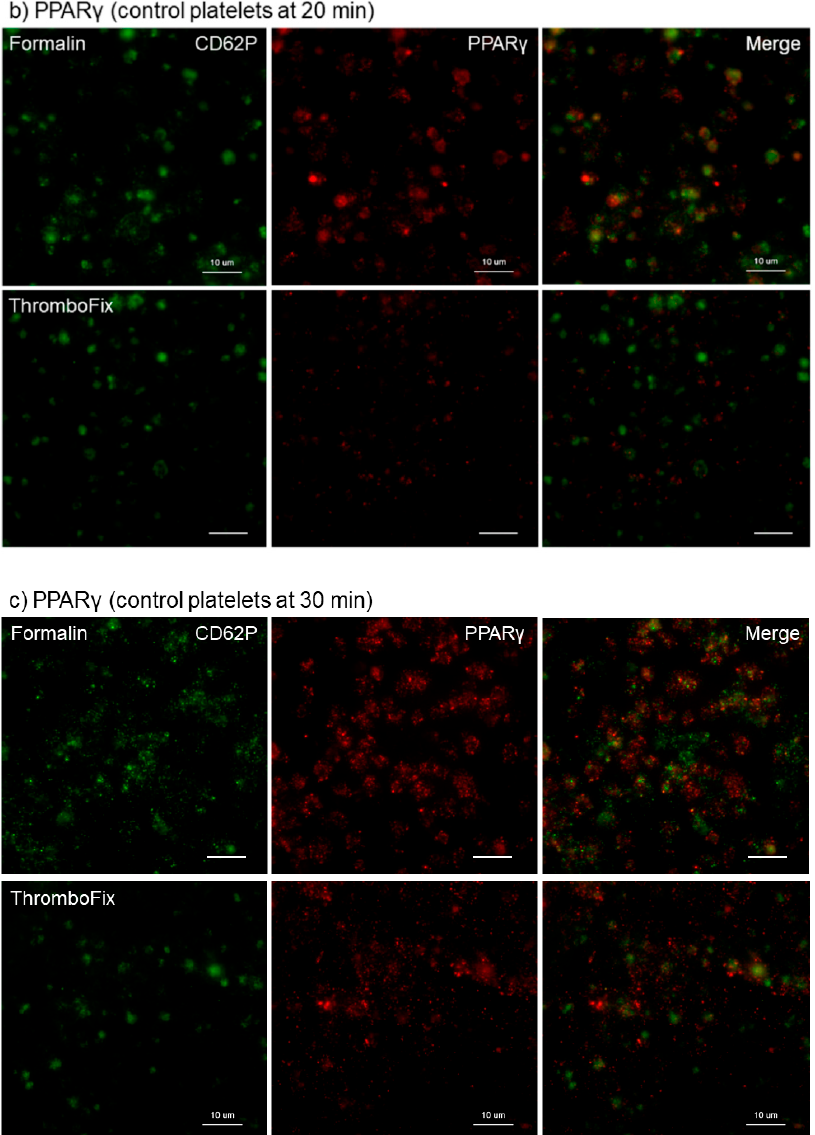
Figure 1. Different effects of fixatives on visualization of PPAR γ in control platelets adhered onto cp- Ti plates. Platelets suspended in PBS were incubated on cp -Ti plates for ( a ) 10 min, ( b ) 20 min, or ( c ) 30 min and fixed with 10% neutral buffered formalin or ThromboFix without intensive washing. Activated platelets (CD62P; green) and PPAR γ (red) were visualized by immunofluorescence and their distribution were compared between formalin and ThromboFix. Similar findings were obtained from the samples prepared from the other three donor samples, which were kept separate and tested individually. Bar = 10 μ m.